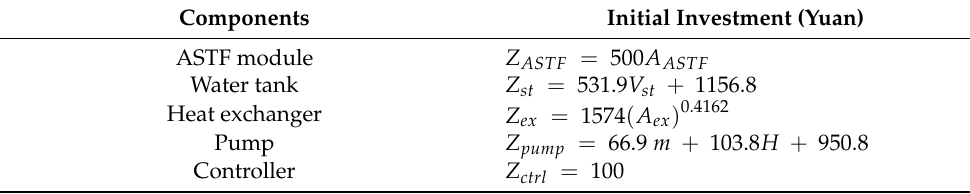
Table 4. Capital cost the ASTF system.